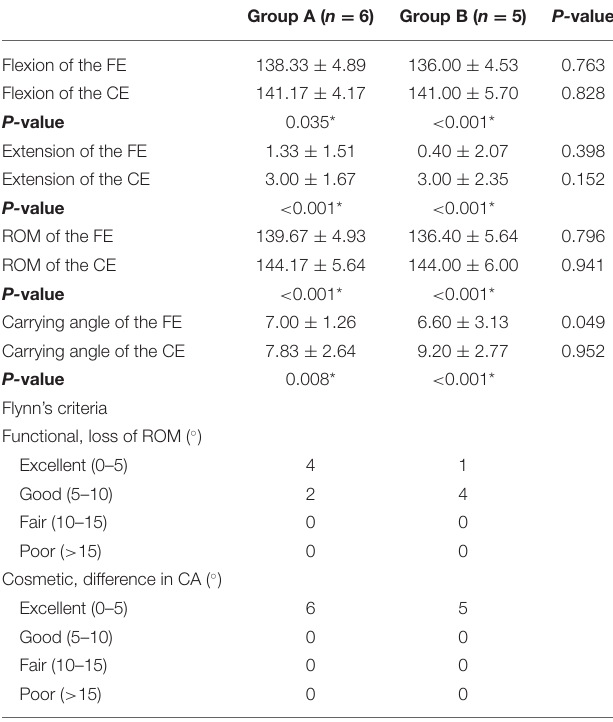
TABLE 3 | Clinical outcomes of successful CR in two